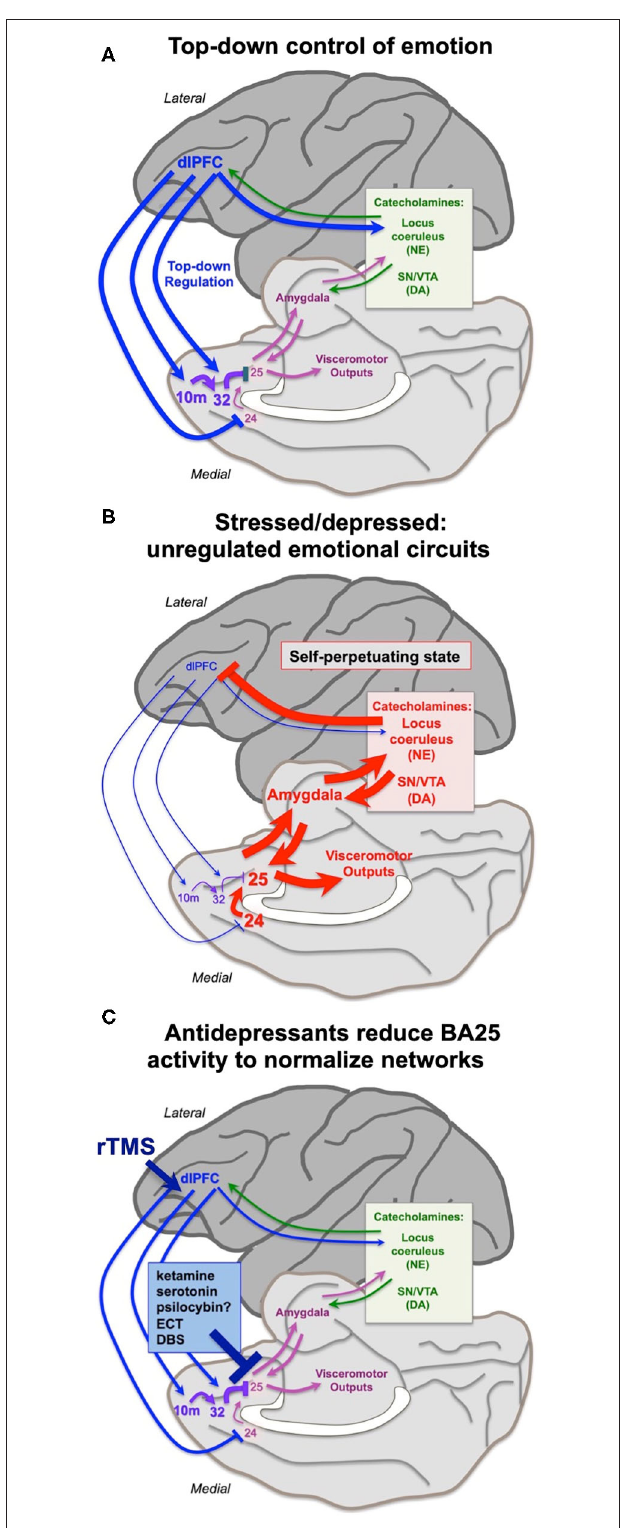
FIGURE 4 | Hypothesis regarding the state of cortical circuits under conditions of health vs. depression, and their normalization by antidepressant